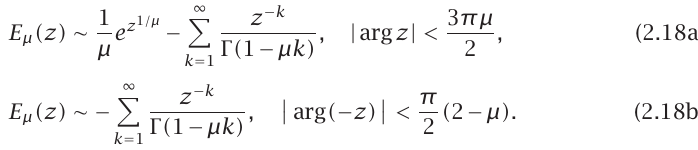
Using the integral representation in (2.14), it is shown in [4, 14] that for 0 < µ < 2, the controlling factor of the leading behaviour of E µ (z) is e z 1 /µ as z → ∞ . Stokes lines occur at Re z 1 /µ = 0 or arg z = ± πµ and anti-Stokes lines occur at Im z 1 /µ = 0 or arg z = ± (π/ 2 )µ